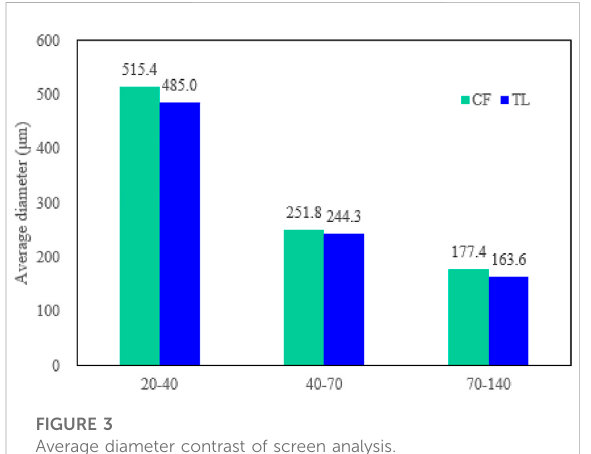
FIGURE 4 Comparison of turbidity test